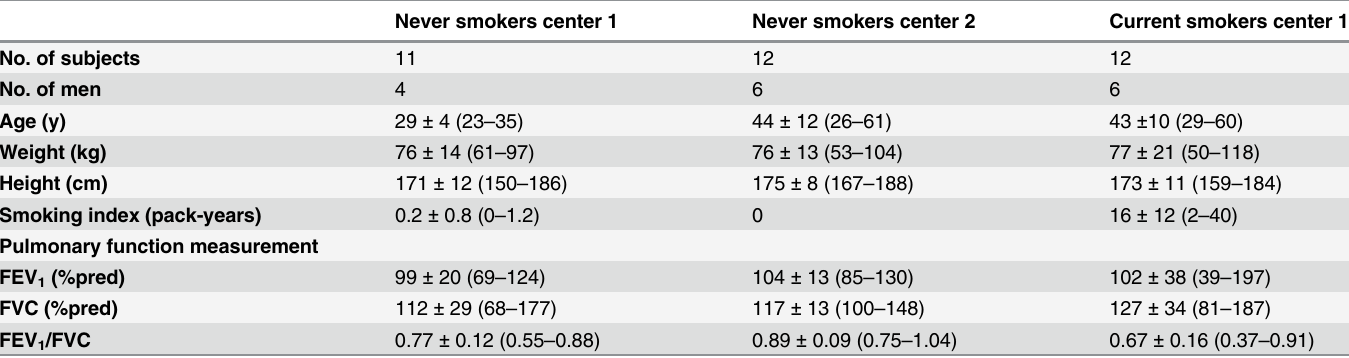
Table 1. Demographic and pulmonary function